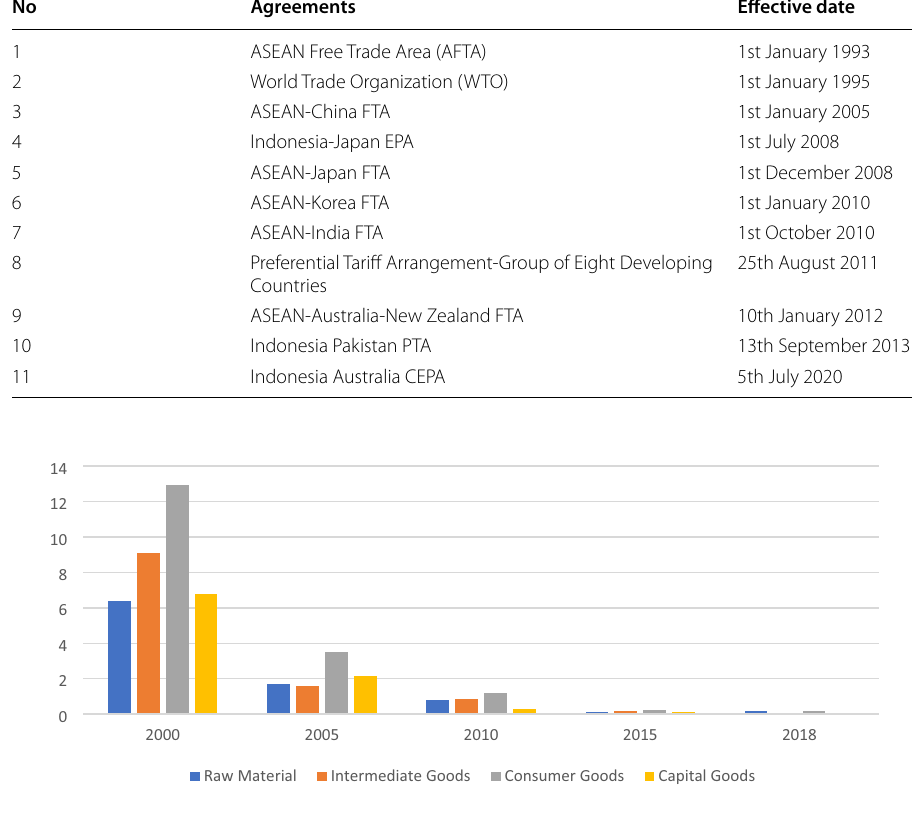
Fig. 4 Average import tariffs on Indonesia export to ASEAN countries. Value of average import tariffs is in percent. Source: www. wits. world bank.